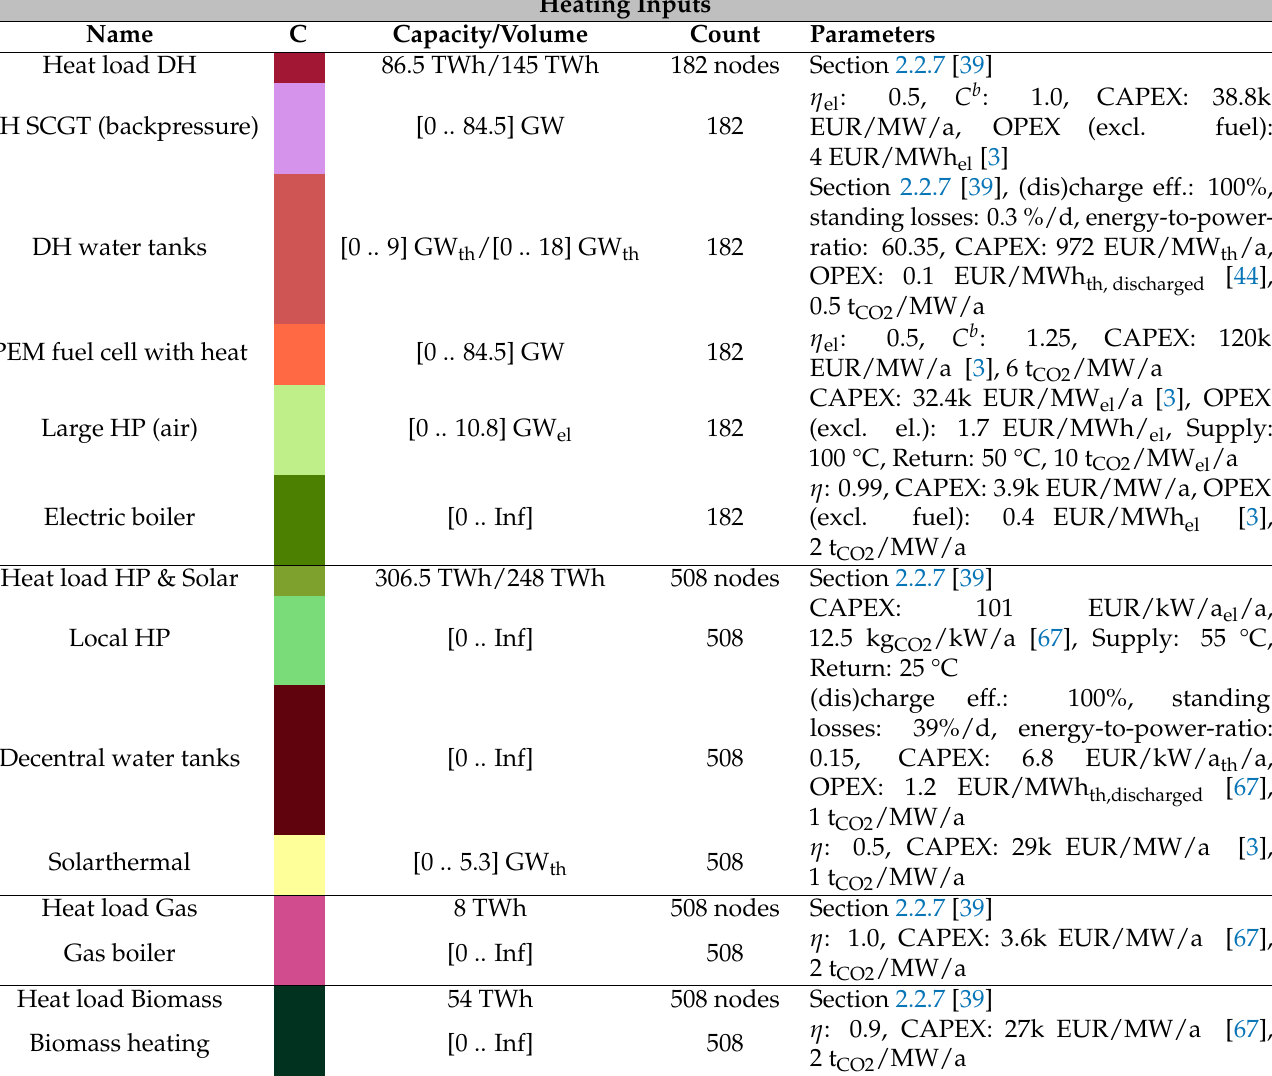
Table A1. Parameter table